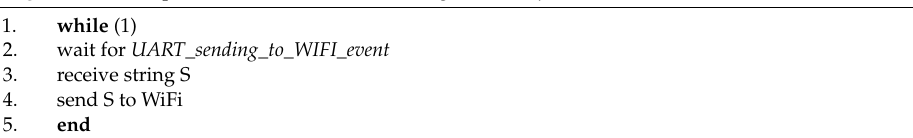
Algorithm 7: The pseudo code of the Trans_Message_to_WiFi